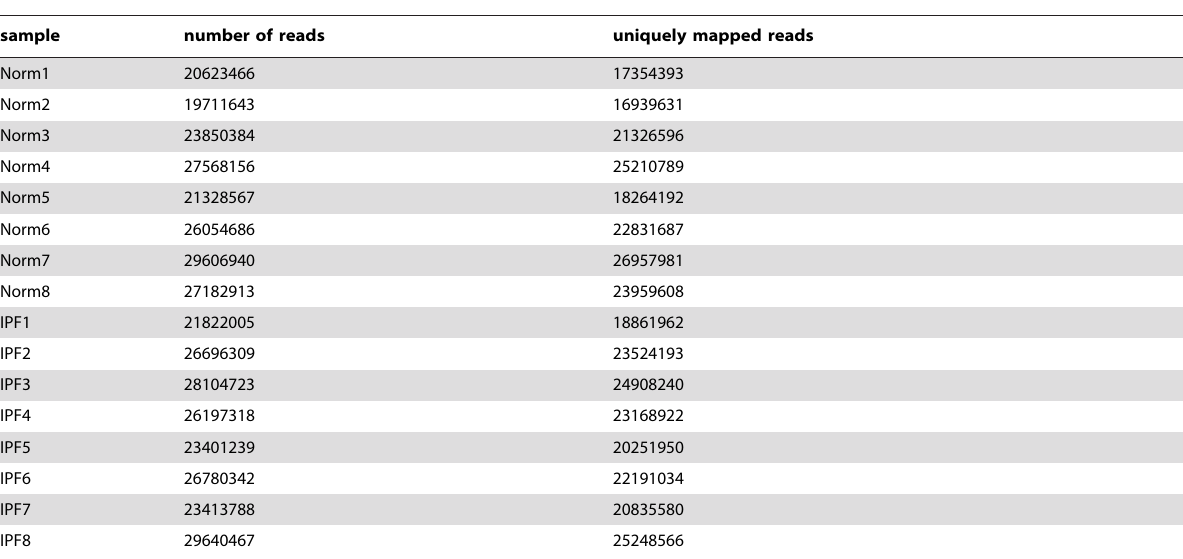
Table 9. Numbers of reads sequenced for each sample.